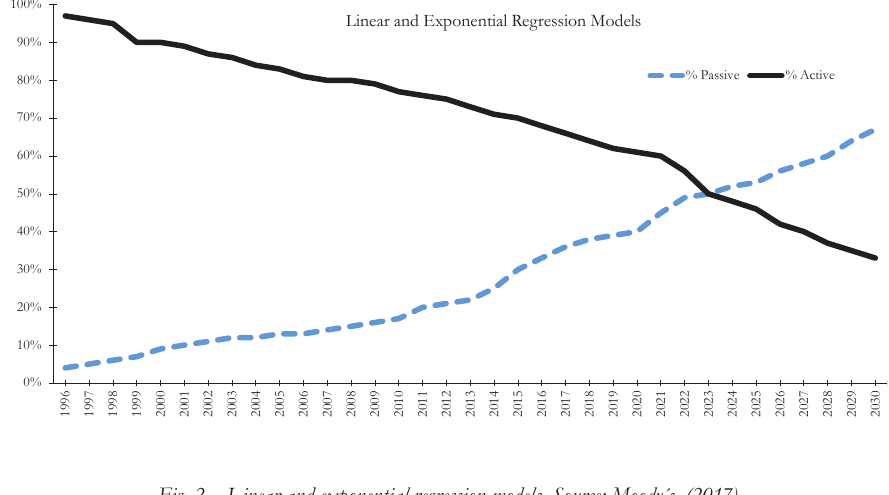
Fig. 2 – Linear and exponential regression models. Source: Moody´s.